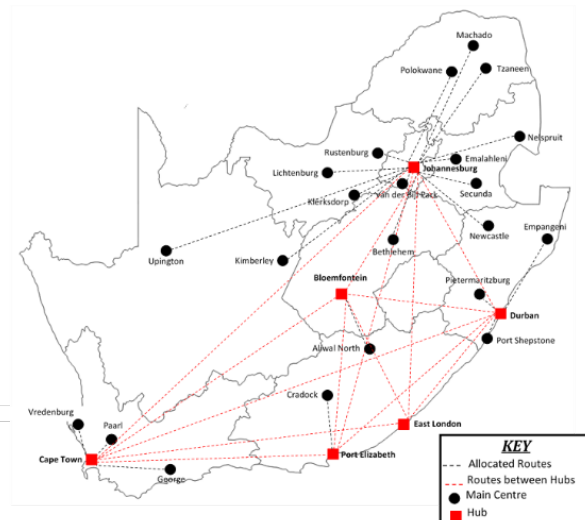
Figure 2: Company’s distribution